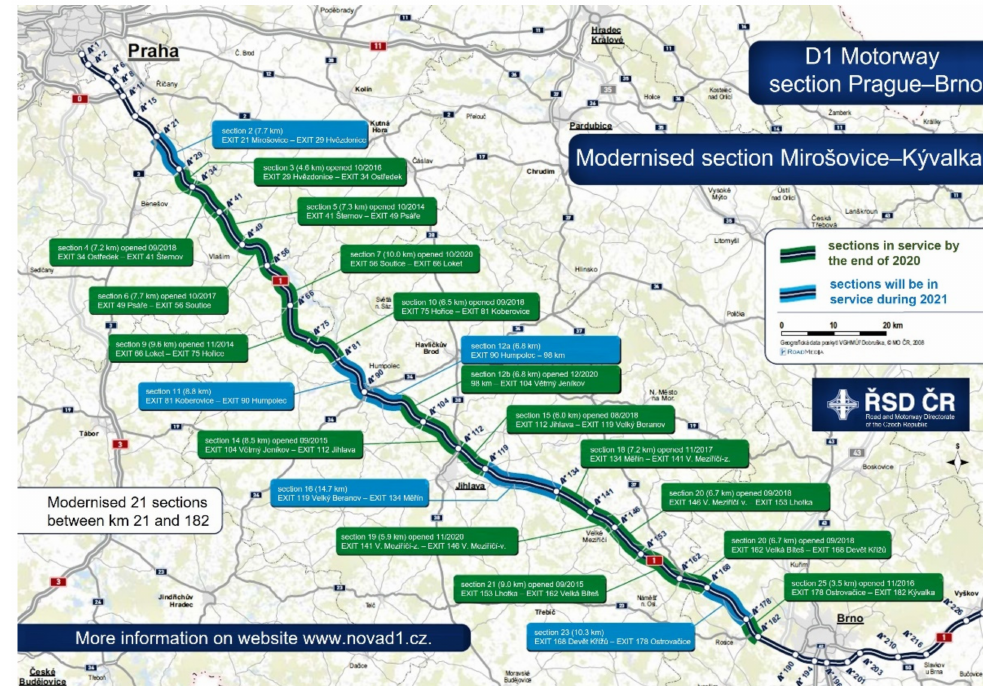
Figure 3. Sections of the D1 motorway in the Czech Republic that are being modernised. Green indicates the sections that were fully opened for operation by the end of 2020, blue marks the sections that are planned to be completed in 2021 (edited according to the source available from: https://www.novad1.cz/) (accessed on 5 July